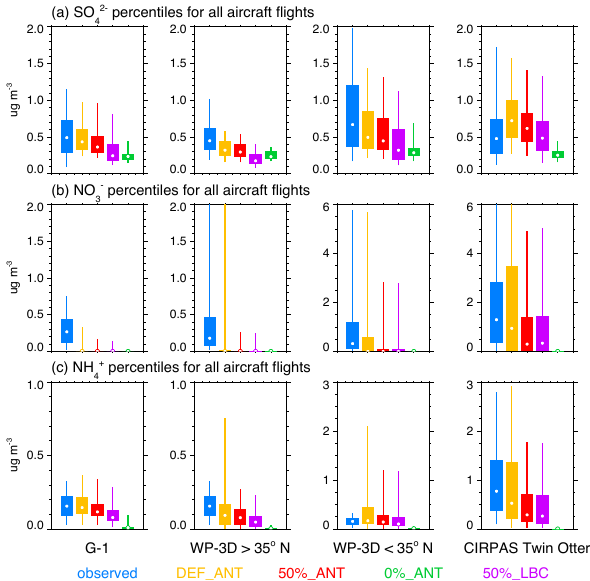
) , and (b) nitrate Figure 20. Percentiles for (a) sulfate (SO 2 − 4 ) , and ammonium (NH + ) for all G-1, WP-3D, and CIRPAS (NO − 3 4 Twin Otter flights. Vertical lines denote 5th and 95th percentiles, boxes denote 25th and 75th percentiles, and the white dots denote the 50th percentiles. Note the scale differs for the northern and southern flights for NO − and NH + 3 4